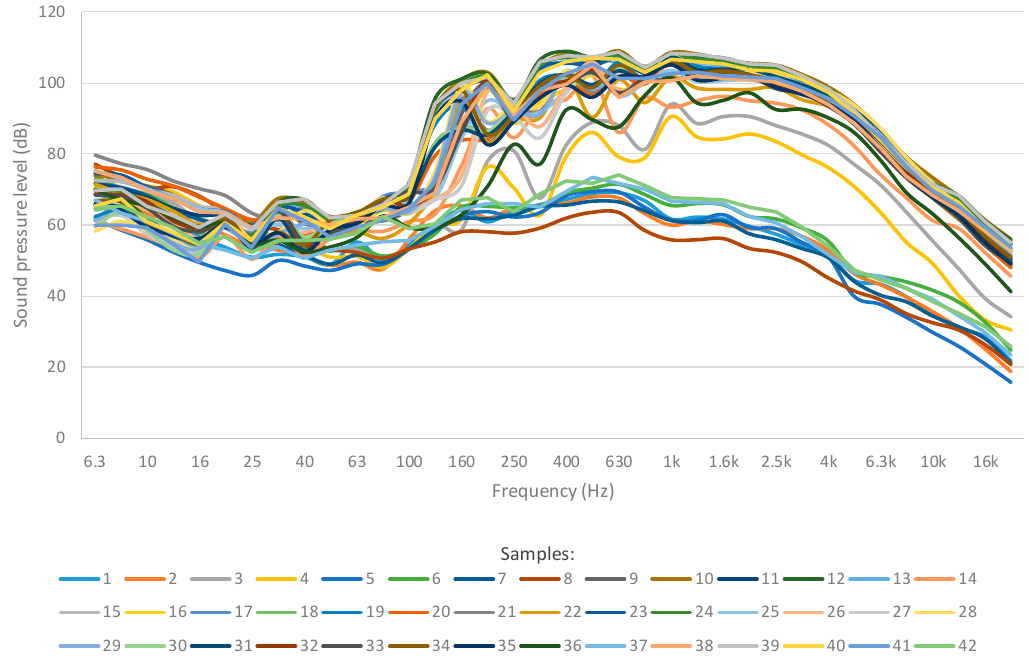
Figure 6. Evolution of the continuous sound pressure level for each frequency band.